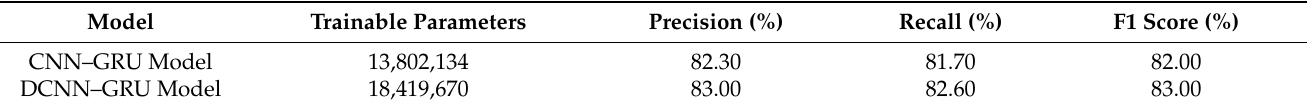
Table 7. Parameters and various accuracy measures for custom models.